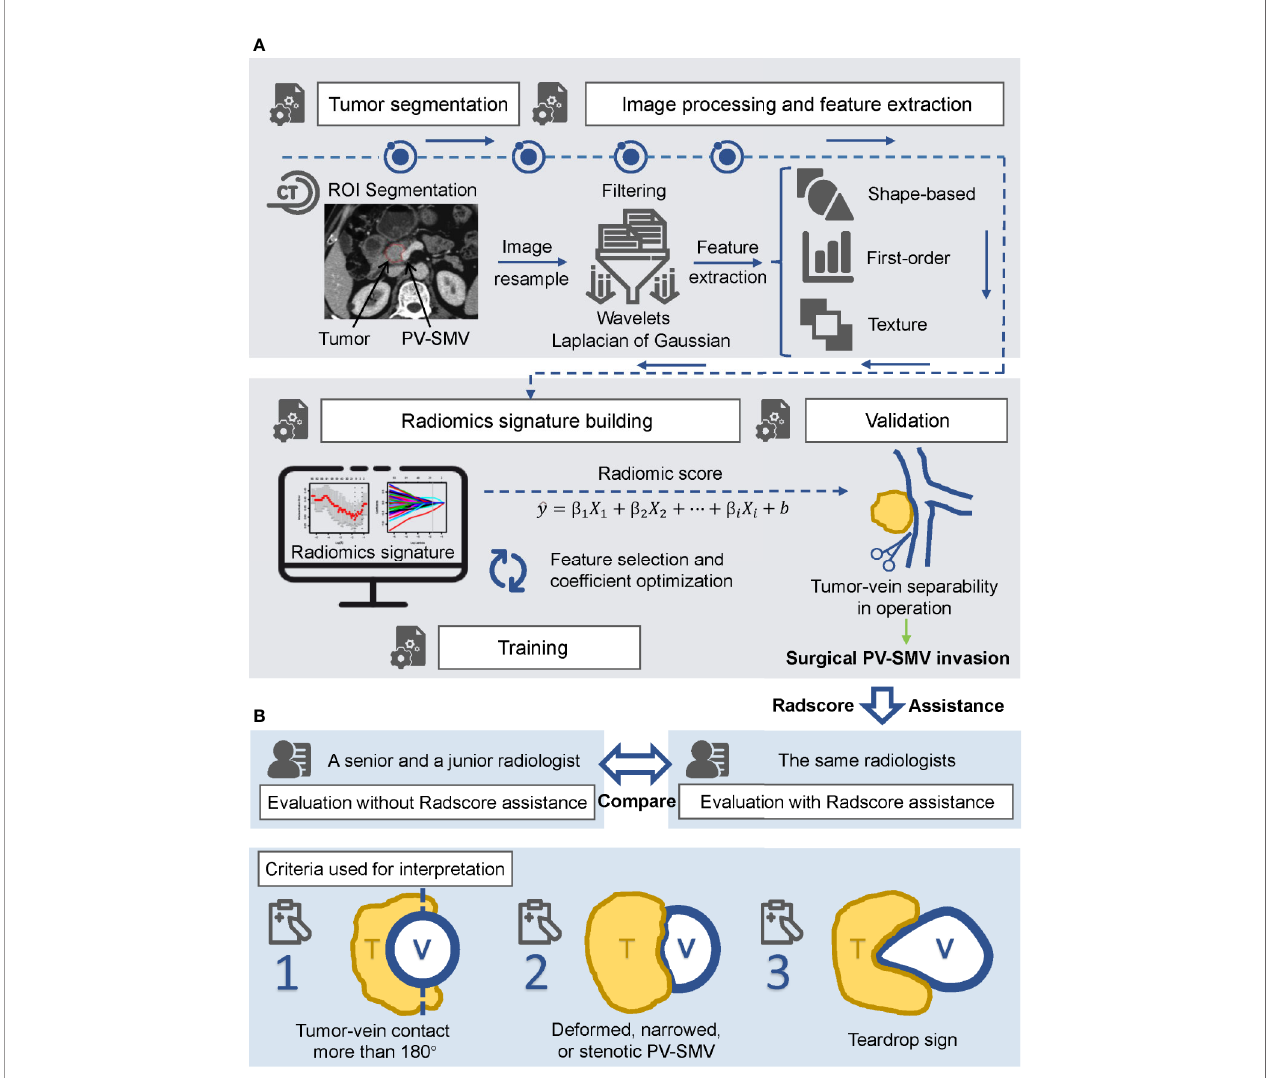
FIGURE 2 | Flowchart of the study. (A) Radiomics work fl ow, including ROI segmentation, feature extraction, radiomics signature construction, and validation. (B) Radiologists assessment. Performance of each radiologist between unassisted evaluation and Radscore-assisted evaluation was compared in the validation cohort. Radscore, radiomics